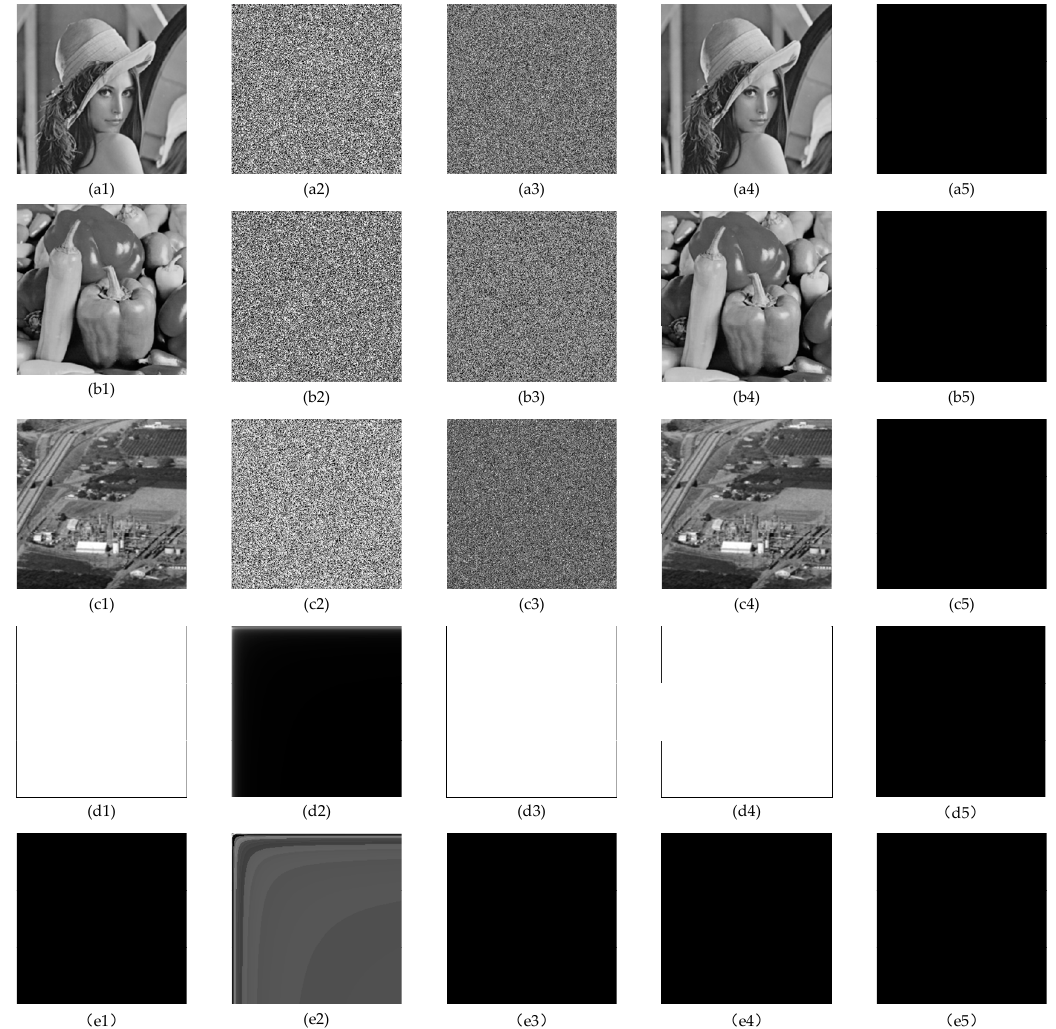
Figure 7. The effectiveness of the proposed cryptanalysis: images from column 1 to column 5 show plain images, cipher images, retrieved permutation-only images, final recovered images, and XOR results for column 1 and column 4, respectively.